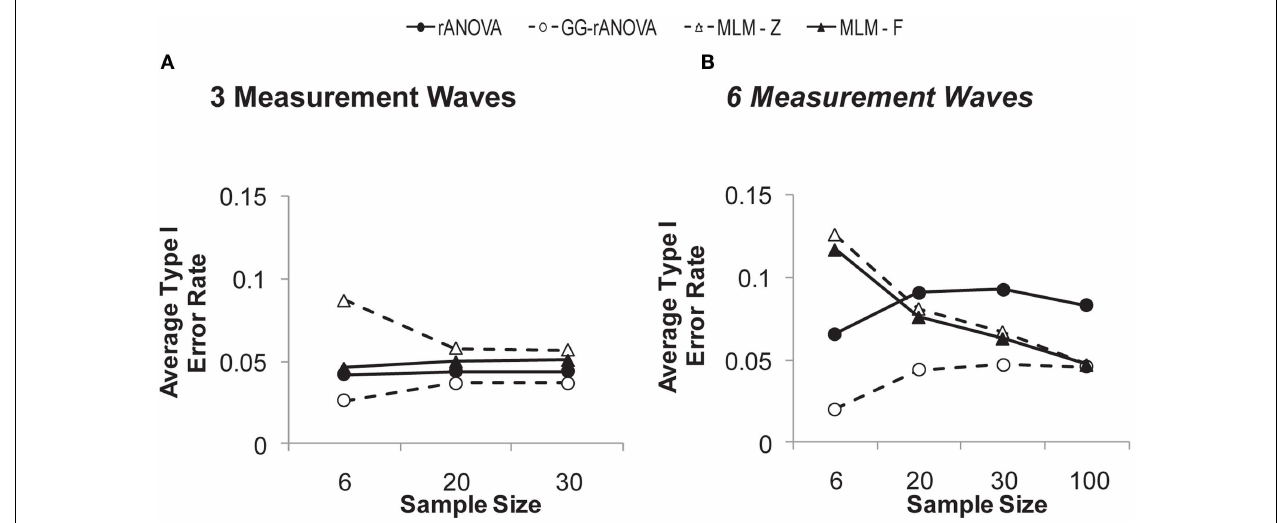
FIGURE 4 |Type I error rates on the session by group interaction with (A) three and (B) six measurement waves .